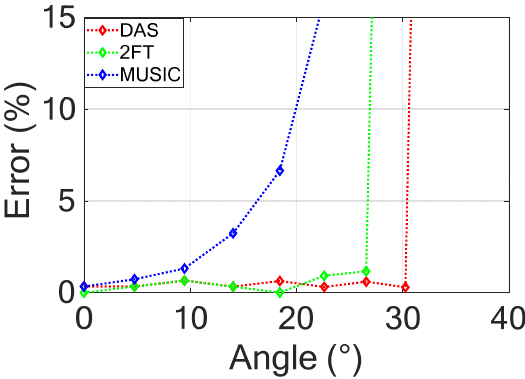
Figure 16. Target position error versus identification ϑ angle shown in Figure 13 for the three considered techniques.